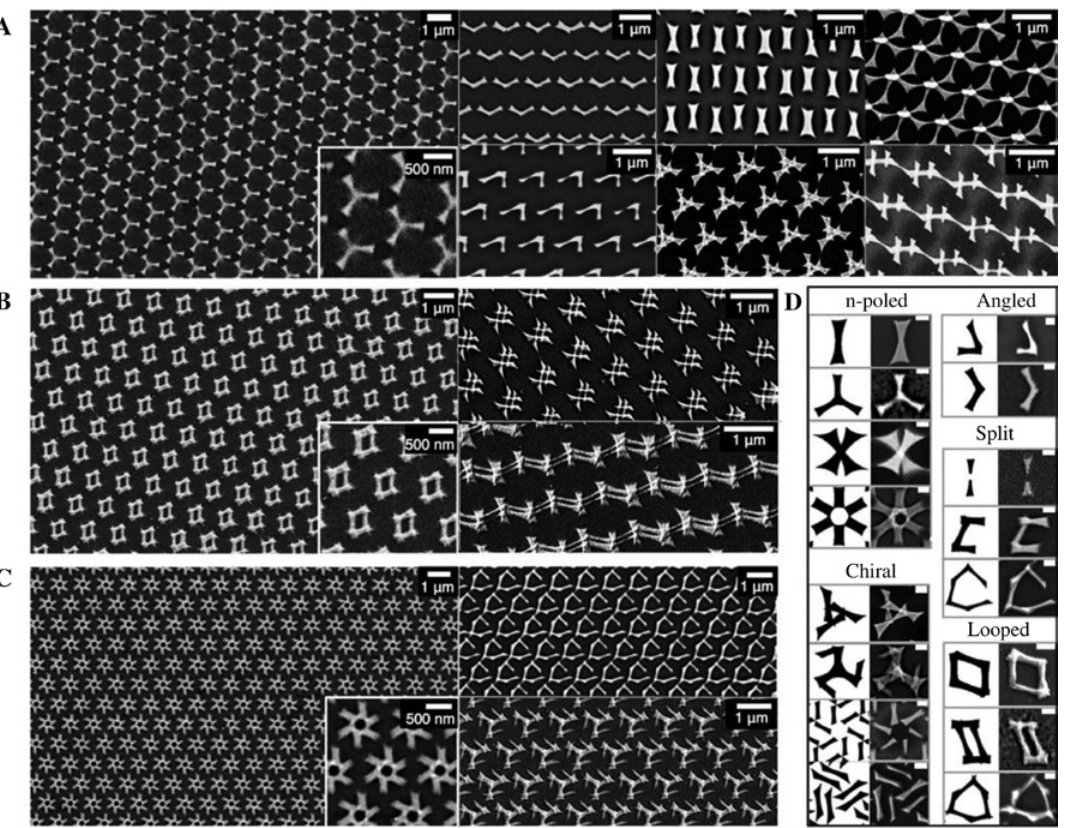
Figure 12: SEM images of nanoantennas designed and fabricated by SSL. Patterns composed of two to three (A), four (B), and five to six (C) different angles of deposition. (D) Subset of possible unit cells categorized according to optical function as designed (left) and fabricated (right), adapted from Ref.